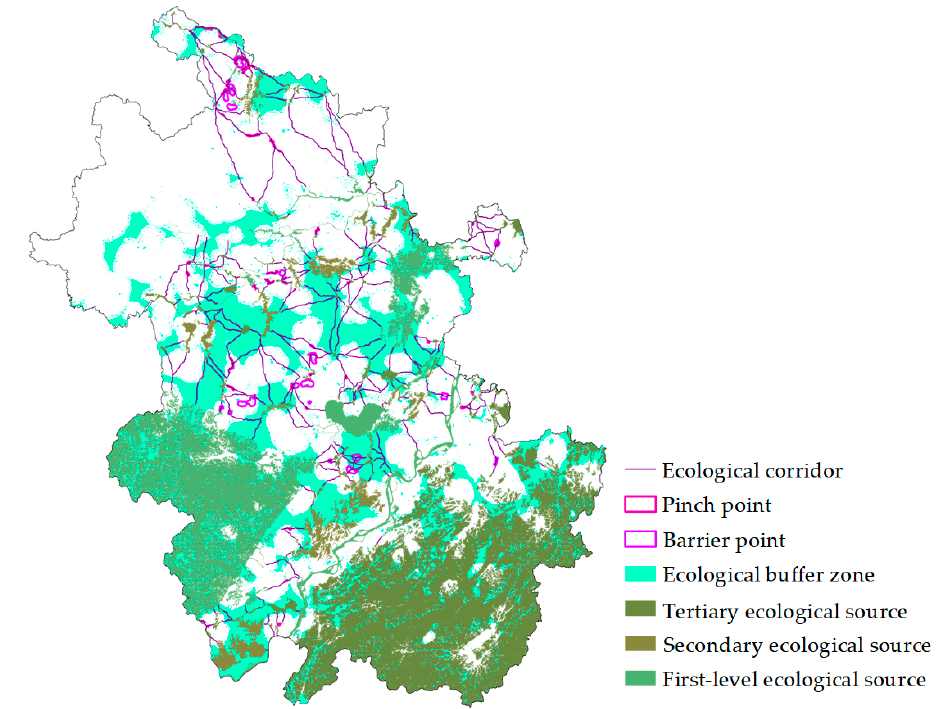
Figure 10. Construction of ecological security patterns in Anhui Province.